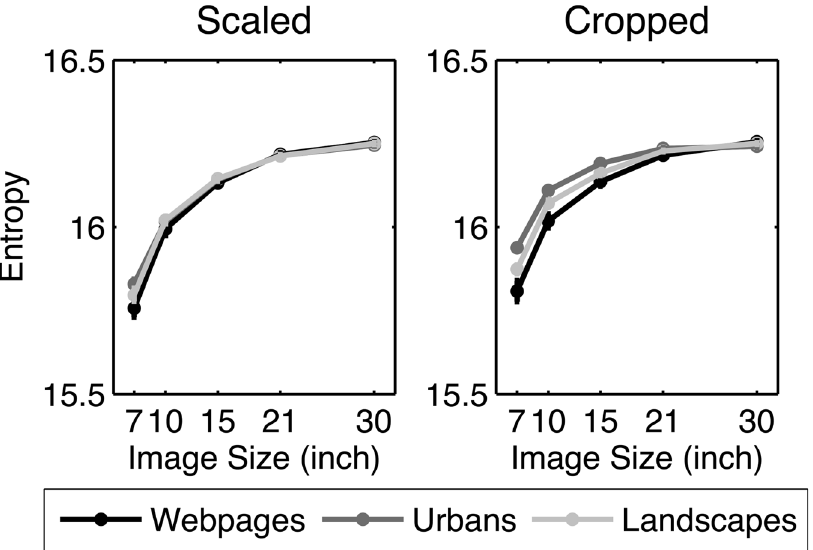
Figure 4. Geometrically independent distribution of fixations in image space operationalized by entropy for each image category and size. Error bars indicate the standard error of the